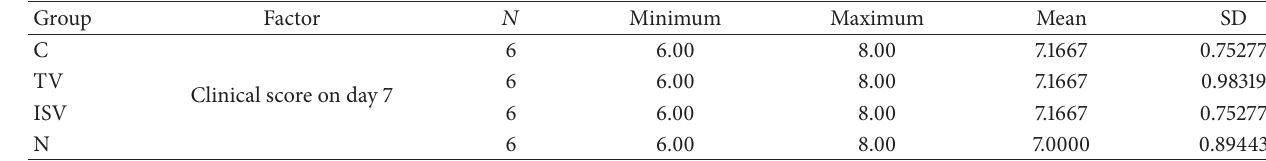
Table 2: Mean clinical scores obtained from each group on day 7.